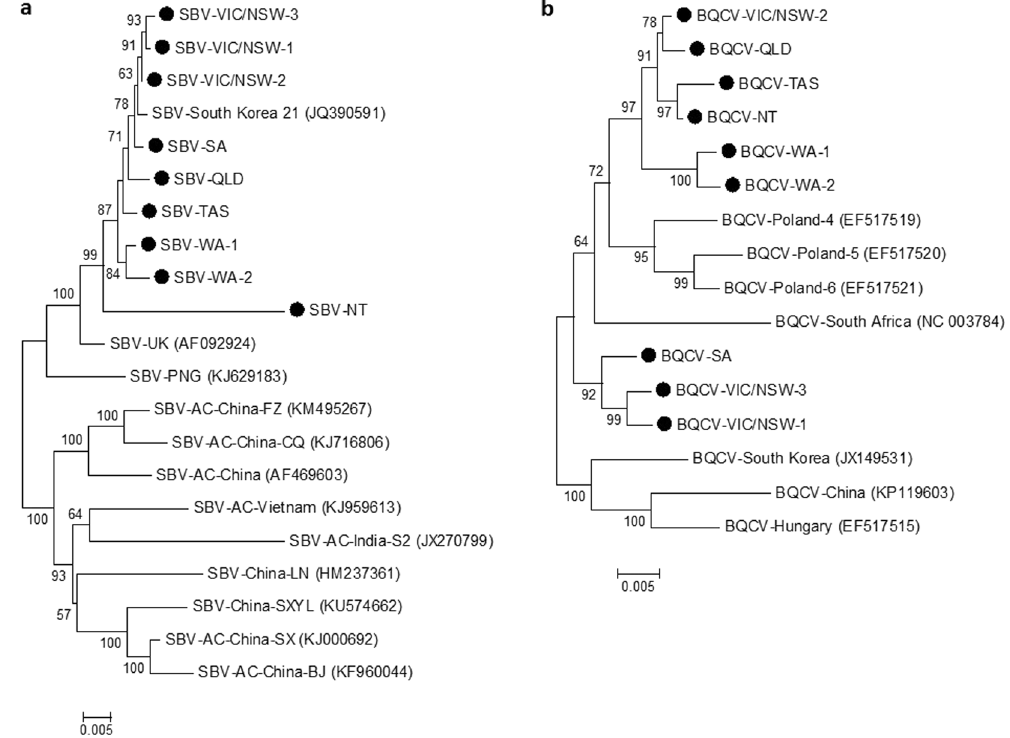
Figure 2. Maximum likelihood consensus tree of ( a ) SBV isolates based on 2,761 amino acids where AC indicates isolates obtained from A. cerana and ( b ) BQCV isolates based on 2,412 amino acids. Isolates from this study are indicated by ( ●